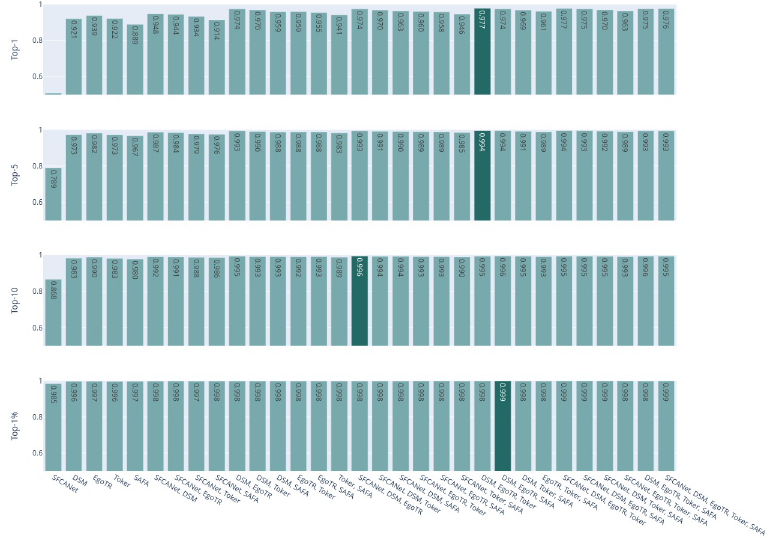
Fig 8. CVUSA combinations for hard-voting with the most accurate model prediction